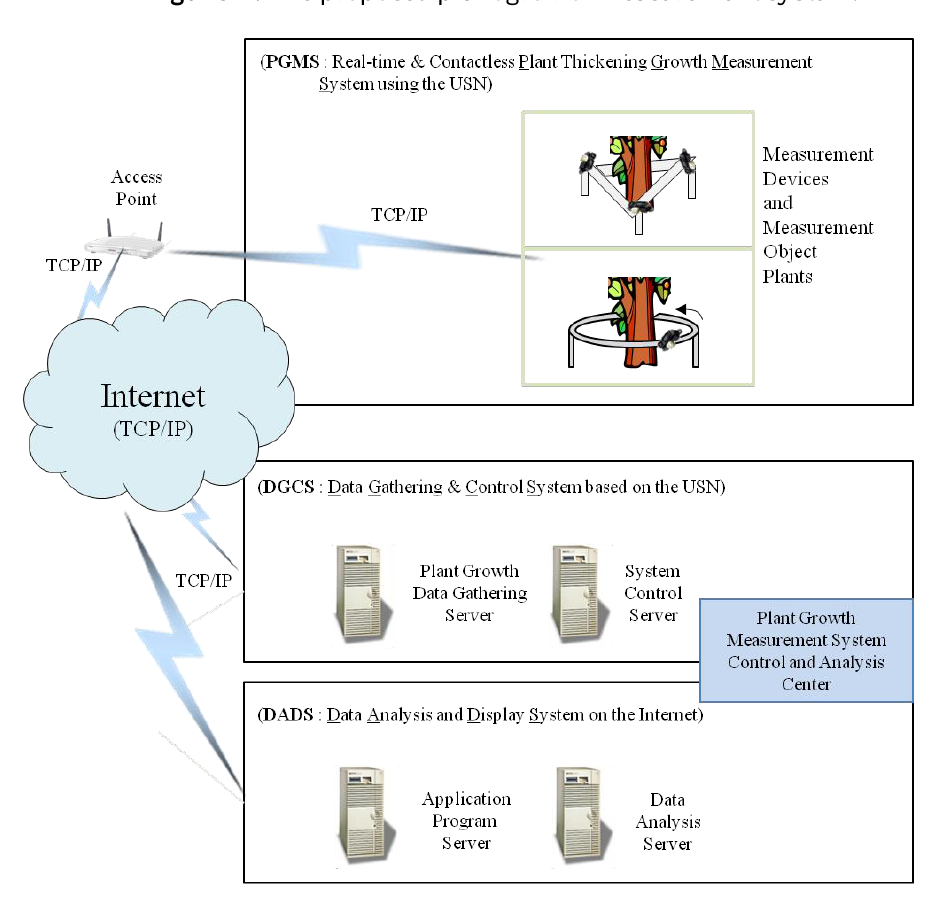
Figure 7. The proposed plant growth measurement